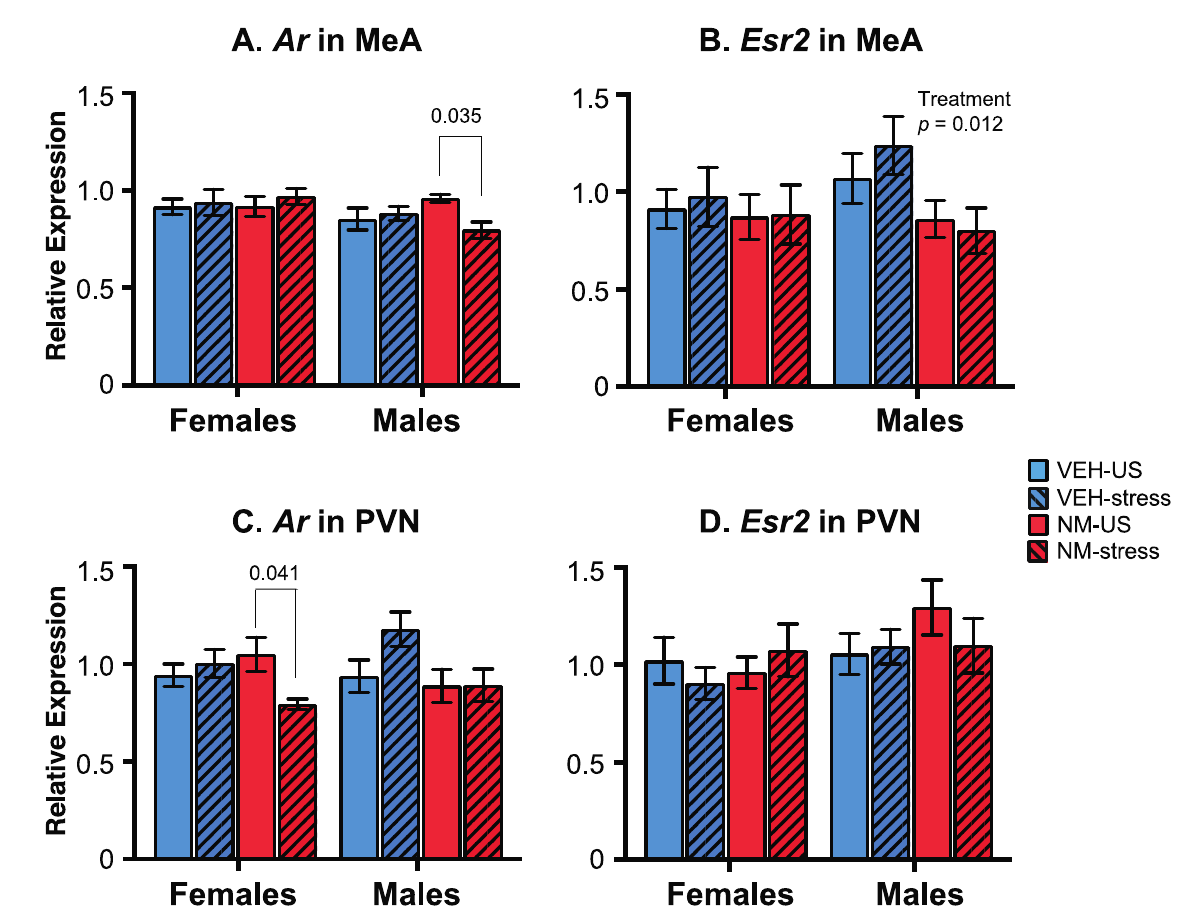
Figure 7. Effects of prenatal NeuroMix and/or stress in adolescence on gene expression in the medial amygdala (MeA) and the paraventricular nucleus (PVN). ( A ) For Ar in the MeA, a significant interaction of stress and treatment was found in males. ( B ) In the MeA, Esr2 was significantly decreased by NeuroMix in males. ( C ) Ar in the PVN had an interaction of treatment and sex in females. ( D ) Esr2 was unaffected in the PVN. n = 11–12 per group. VEH = vehicle; NM = NeuroMix; US = unstressed.